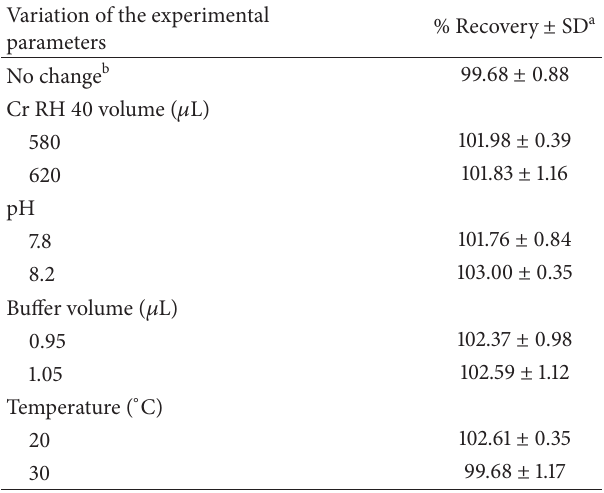
Table 4: Robustness results of the proposed analytical procedure. Variation of the